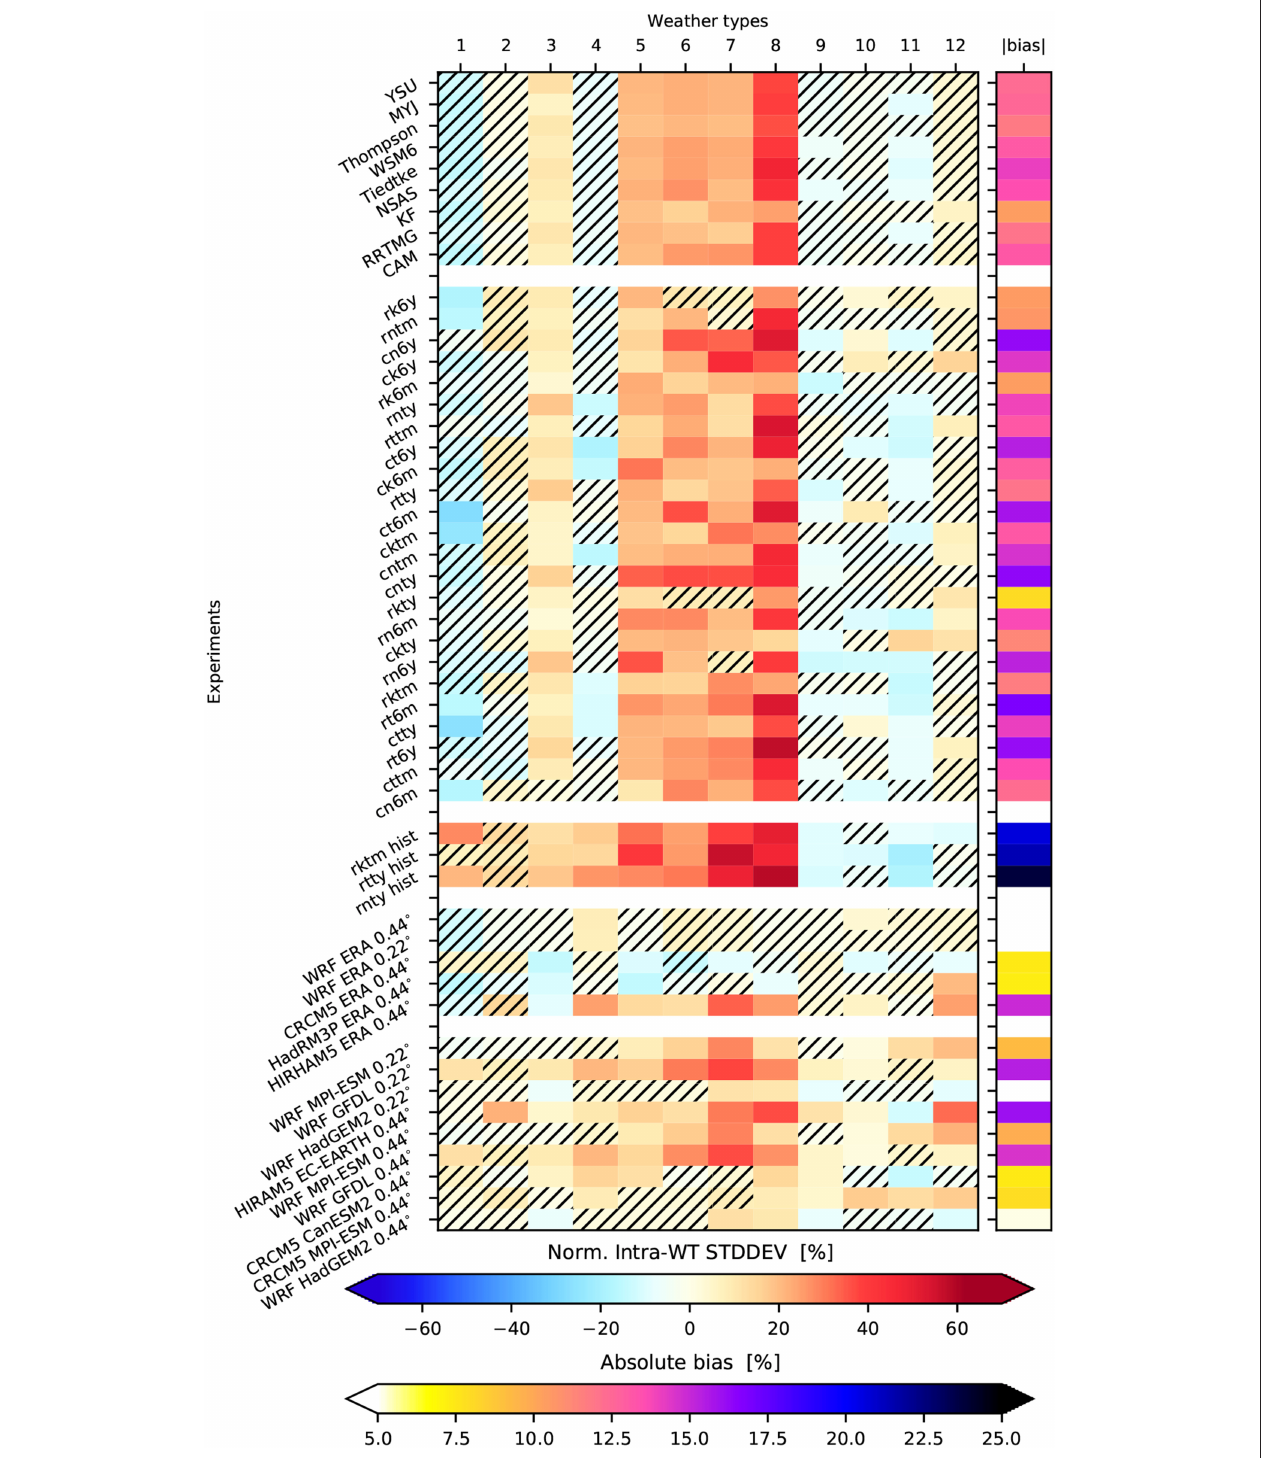
FIGURE 7 | Similar to Figure 6 but showing the simulated divided by ERA-Interim intra-WT pattern standard deviations. A perfect score is zero and denotes that the model has the same variability than ERA-Interim.